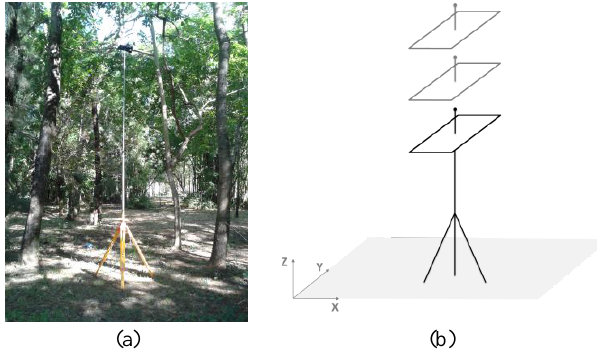
Figure 1. (a) Fisheye system positioned among trees. (b) Acquisition of multiples vertical images with height variation.